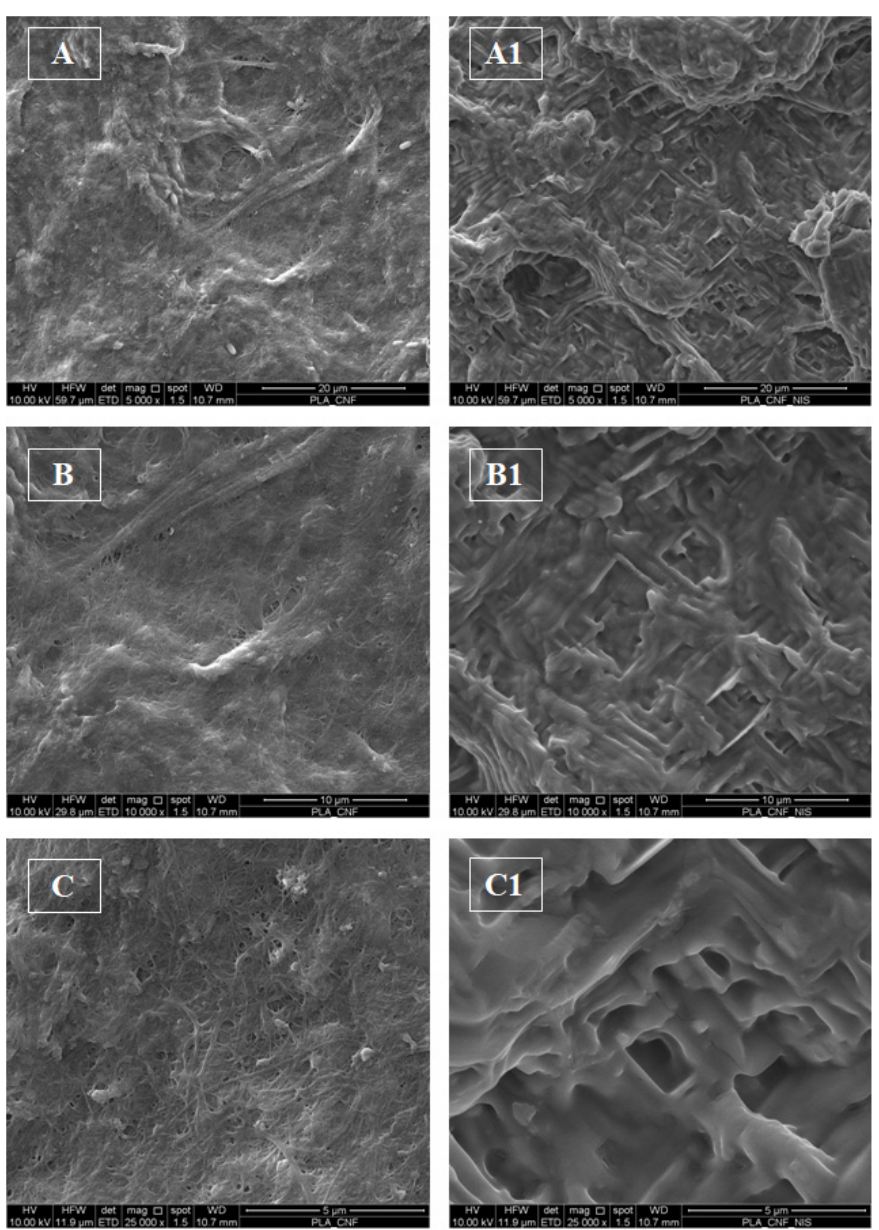
Figure 3. SEM images of CNF/PLA ( left side ) and CNF-Nis+PLA ( right side ) film at 2.5% CNF. A, B, and C: CNF/PLA at 500×, 1000×, and 25000× magnifications, respectively; A1, B1, and C1: CNF-Nis+PLA at 500×, 1000×, and 25000× magnifications, respectively.